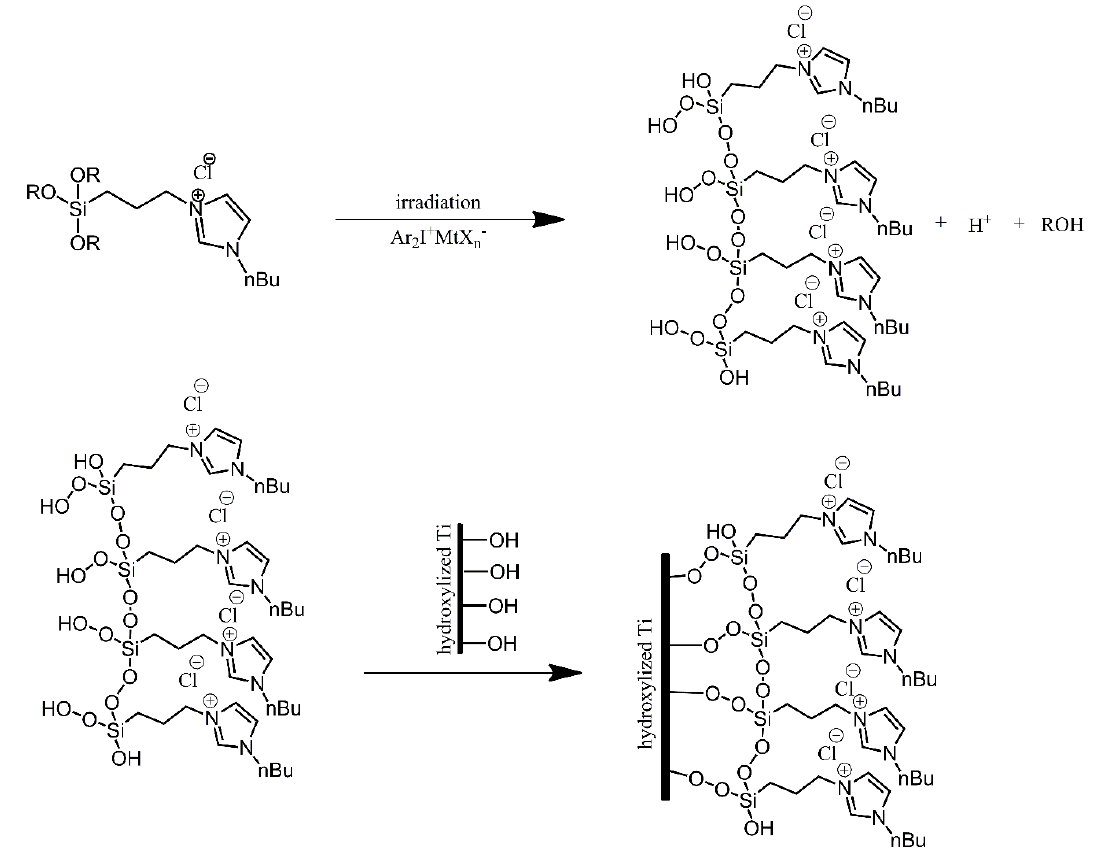
Figure 6. Photografting of the imidazolium-derived siloxane on a titanium plate. Based on Ref. [2].